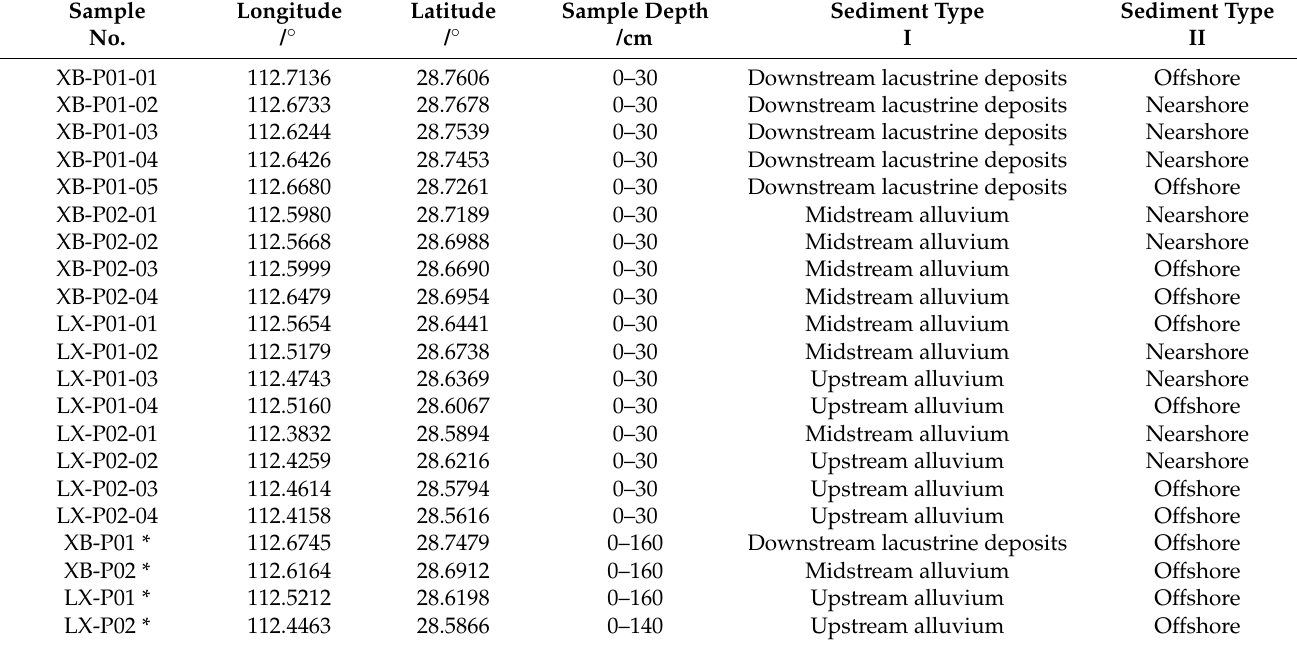
Table 1. Basic information for the soil